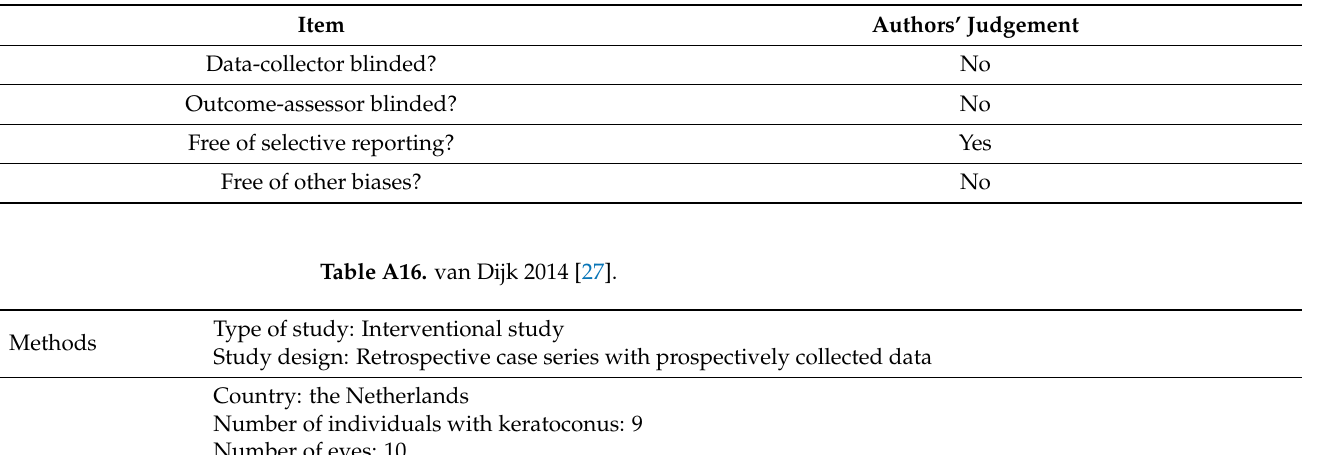
Table A15. Risk of bias.